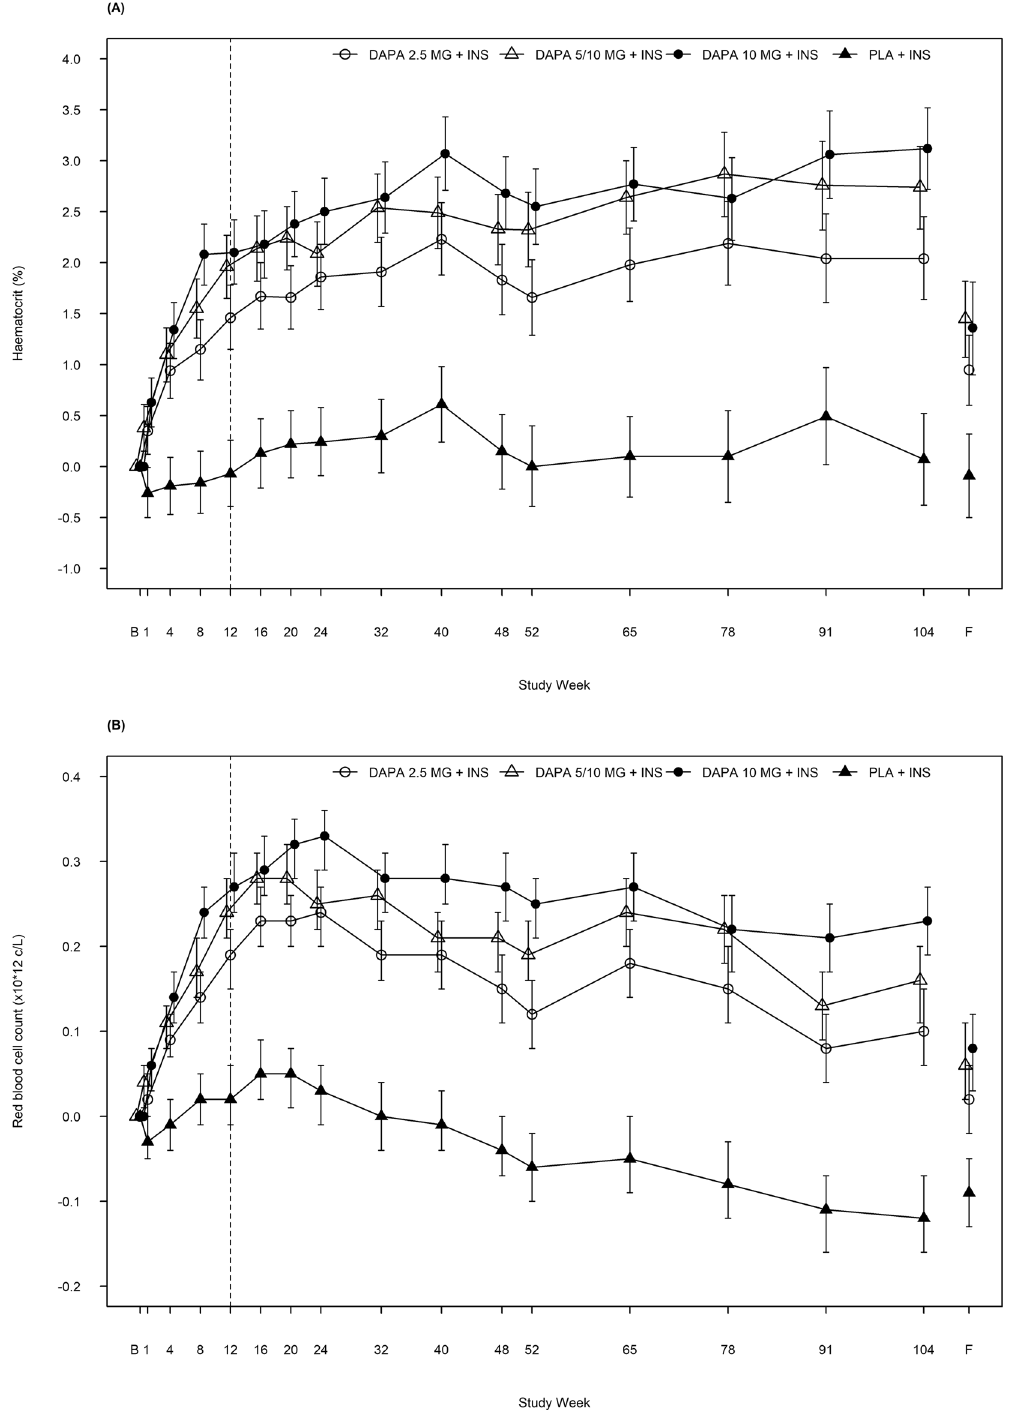
Figure 1. Effect of dapagliflozin on haematocrit, red blood cell and reticulocyte counts. Adjusted mean change from baseline for ( A ) haematocrit, ( B ) red blood cell count and ( C ) reticulocyte count over 104 weeks, including follow-up visit. The vertical dotted line marks the short-term study period (12 weeks). Error bars show ± 95% CI. B, baseline; CI, confidence interval; DAPA, dapagliflozin; F, follow-up; INS, insulin; PLA,